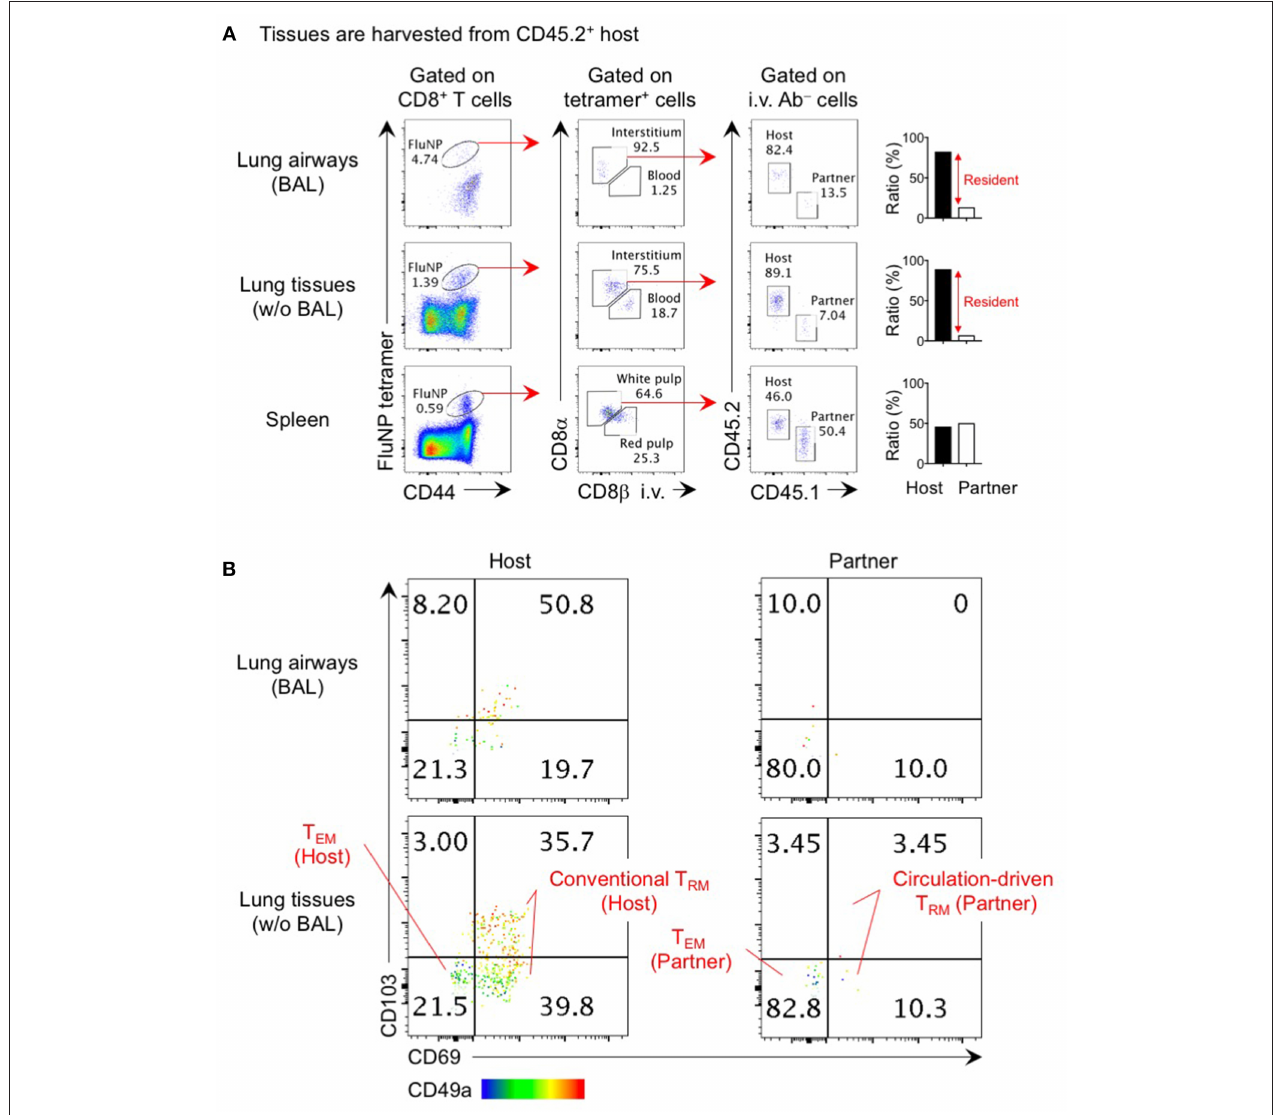
FIGURE 1 | Analysis of lung T RM and T EM by parabiosis experiment. Congenically distinct mice (CD45.1 + and CD45.2 + ) were infected i.n. with influenza virus x31 (300 EID 50 ) and subjected to parabiotic surgery 35 days later. Day 21 after the surgery, mice were injected i.v. with 1 µ g anti-CD8 β 3min prior to tissue harvest. Cells in the lung airways were recovered by BAL. Lung tissues were digested by collagenase D, and enriched by centrifugation in 40/80% Percoll gradient. Cells were stained with influenza NP 366 − 374 /D b tetramer and fluorescent-conjugated antibodies. Data shown are derived from a CD45.2 + parabiont. Plots shown in (A) indicate the gating strategy of host- and partner-derived antigen-specific CD8 + T cells in the spleen, lung interstitium and airways. Bar graphs show ratio of host and partner cells among i.v. antibody negative cells in individual mouse. Plots shown in (B) indicate the expression of CD69, CD103, and CD49a on host- and partner-derived NP 366 − 374 /D b tetramer + CD8 + T cells in the lung airways and interstitium. Host cells are the mixture of a large proportion of T RM (CD69 + CD49a + CD103 + and CD69 + CD49a + CD103 − ) and a minor population of T EM (CD69 − CD49a − CD103 − ). The former population may include a small number of circulation-driven T RM converted from host T EM . The data also show how circulation-driven T RM cells are a relatively small population and are difficult to identify in individual